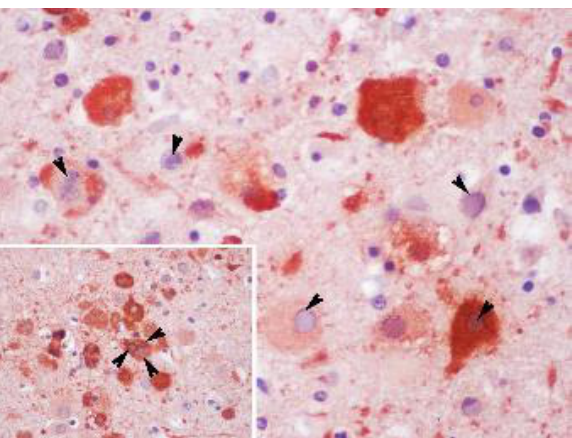
Figure 6 . Brain cerebral cortex sample of case 12, a juvenile male striped dolphin presenting co- infection with DMV, presenting 7/7 of the evaluated brain lesions. Multiple basophilic intranuclear inclusion bodies within the neurons (arrowheads) can be seen with immunostaining against CDV.